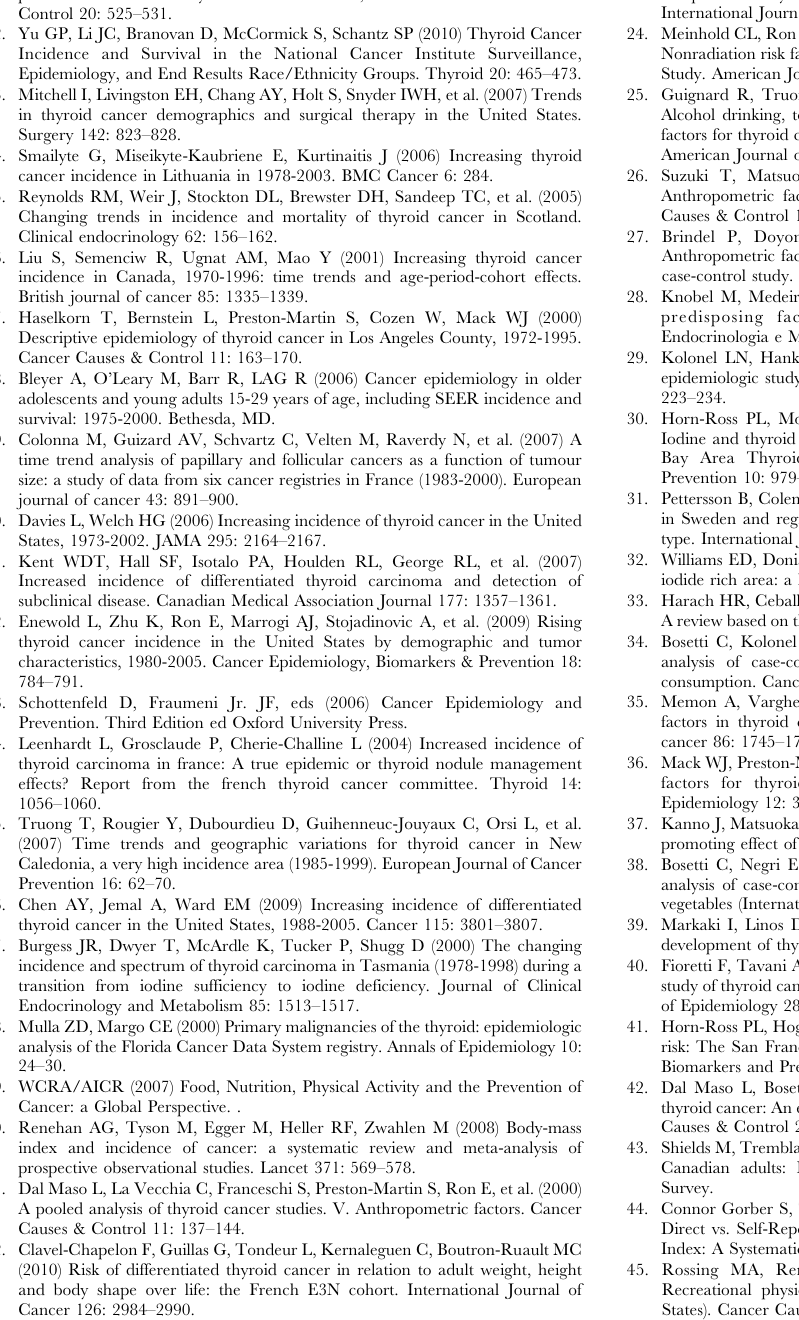
Table S3 Summary of reviewed reproductive factor studies and thyroid